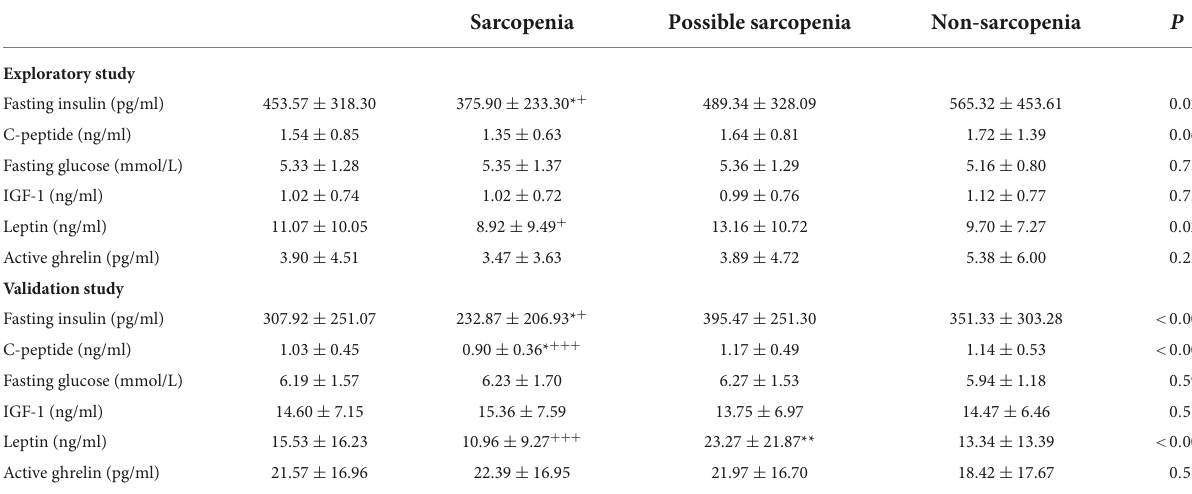
TABLE 3 Odds ratio of association of blood biomarkers with sarcopenia in whole sample.